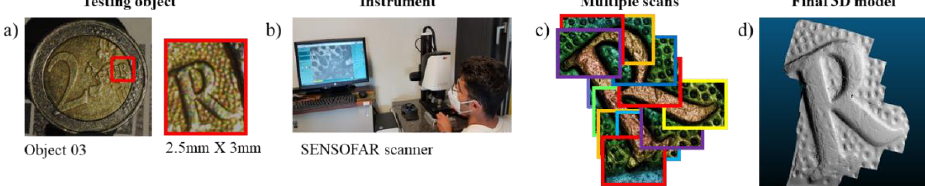
Figure 5. Reference data for high frequency evaluation. (a) A small area (letter R with dimension of 2.5 mm*3mm) on a two Euro coin (Object 03) was selected and measured. (b) The SENSOFAR scanner with optical resolution of 0.5µm and (c) the 12 overlapping scans to form the entire letter (R). (d) Final 3D model after alignment and co-registration of the scans.